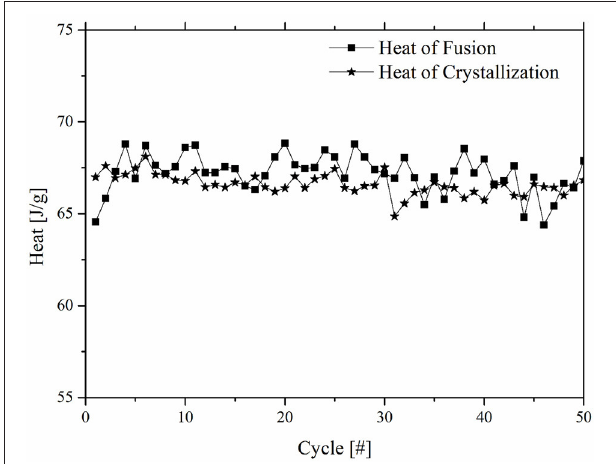
FIGURE 3 | Heat of fusion and heat of crystallization as a function of the number of DSC cycles for TPU_50M6D sample.